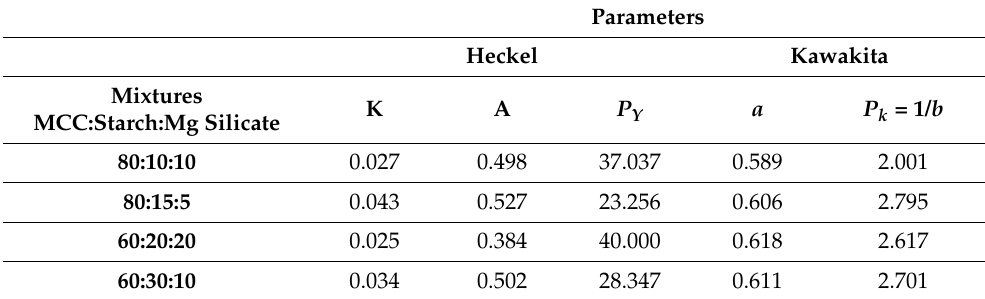
Table 4. Heckel and Kawakita parameters of ternary mixtures of composition nearby the optimum. Parameters Heckel Kawakita Mixtures